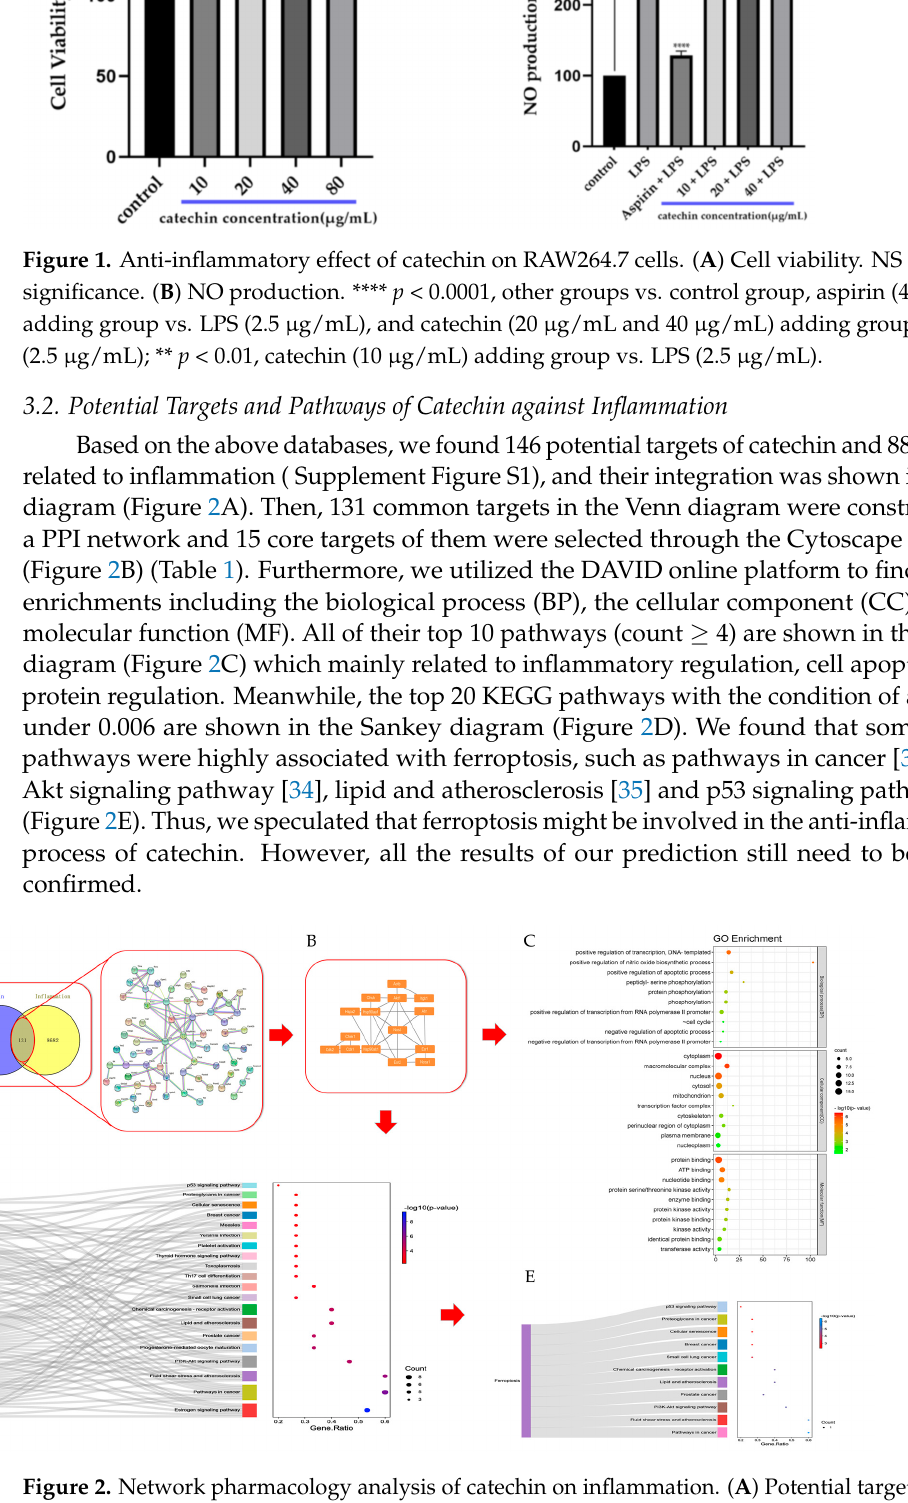
Figure 2. Network pharmacology analysis of catechin on inflammation. ( A ) Potential targets and PPI network. ( B ) 15 core targets. ( C ) Bubble diagram of GO enrichments. ( D ) Sankey diagram of KEGG pathways. ( E ) KEGG pathways related to ferroptosis. Table 1. Information of the core targets.